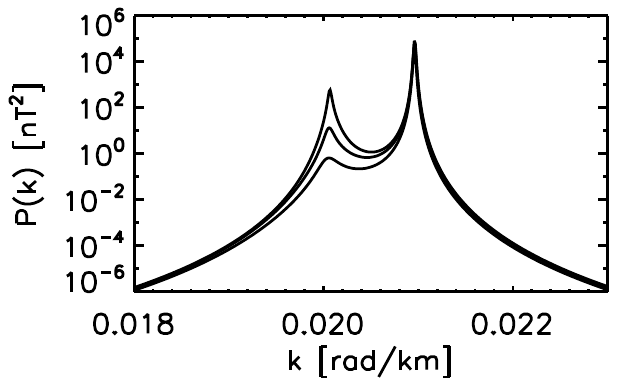
Fig. 6. Wave number spectra for synthetic data with different ratios of fluctuation amplitudes between two waves: 1 / 2 (upper curve); 1 / 5 (middle curve), and 1 / 10 (lower curve).